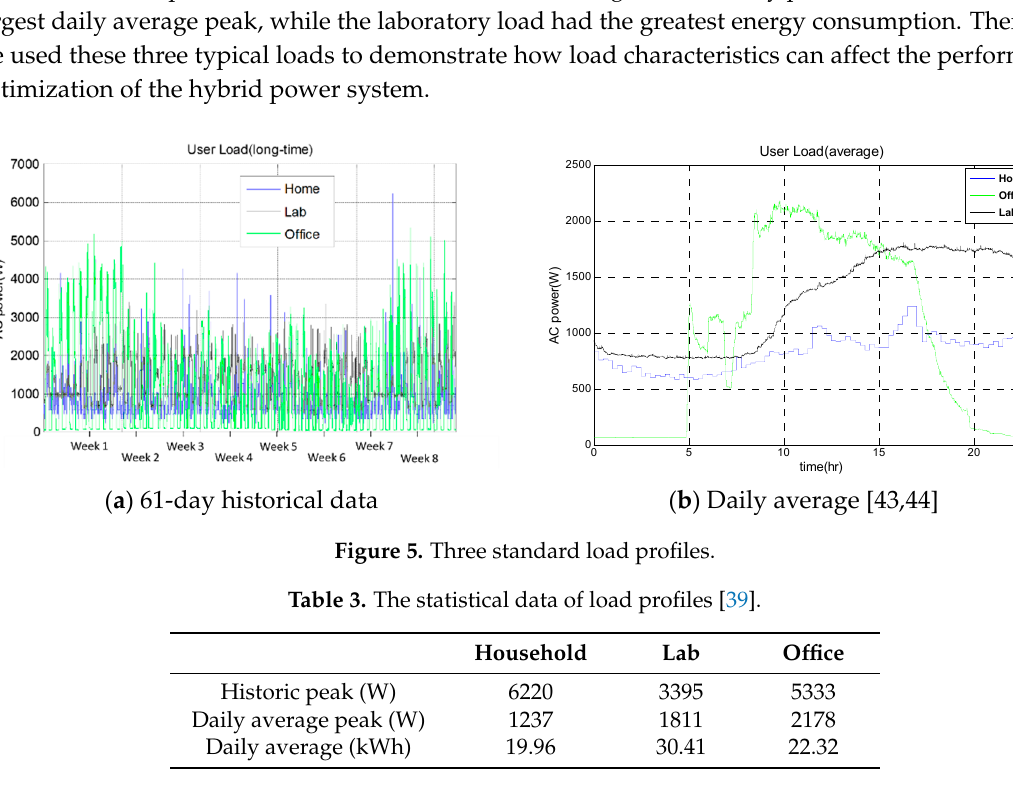
Figure 4. Radiation and wind data.